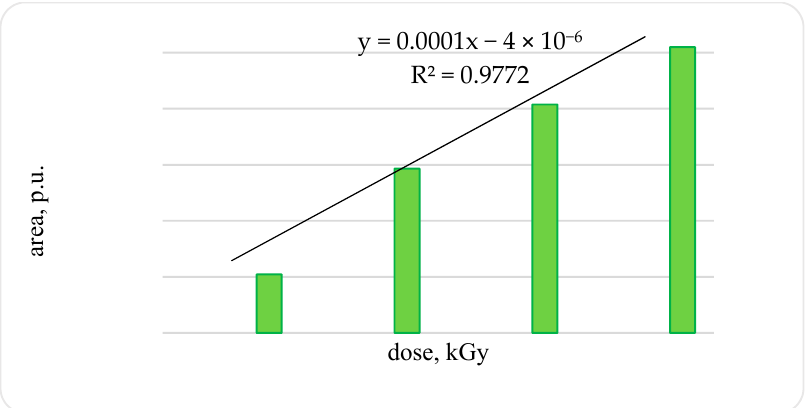
Figure 4. Area of EPR signals samples of bone tissue of rainbow-cooled trout irradiated with different doses.